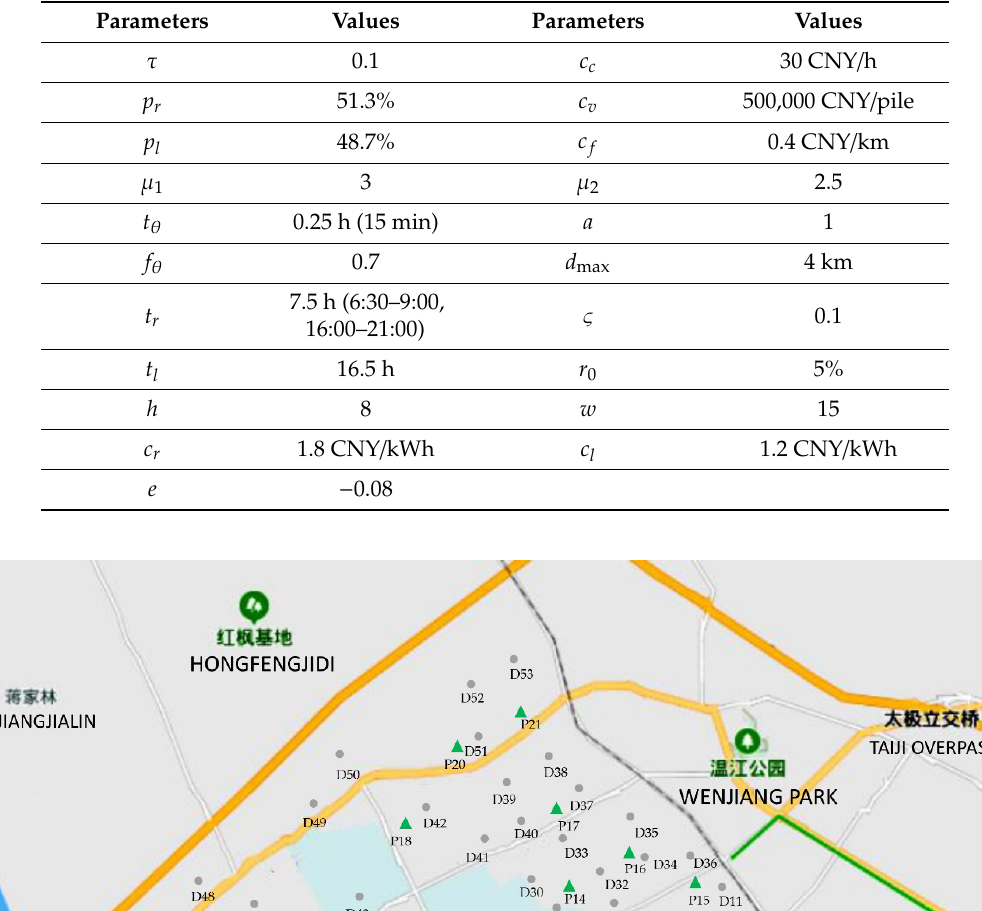
Table 3. The values of necessary parameters.